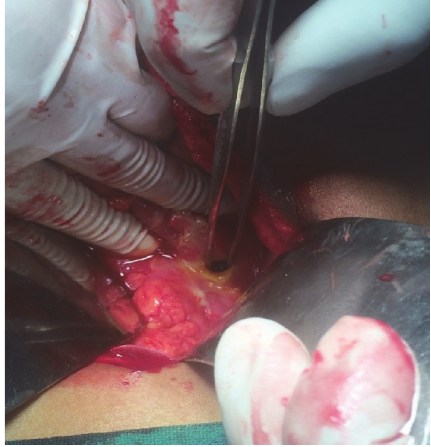
Figure 2: Showing duodenal perforation.